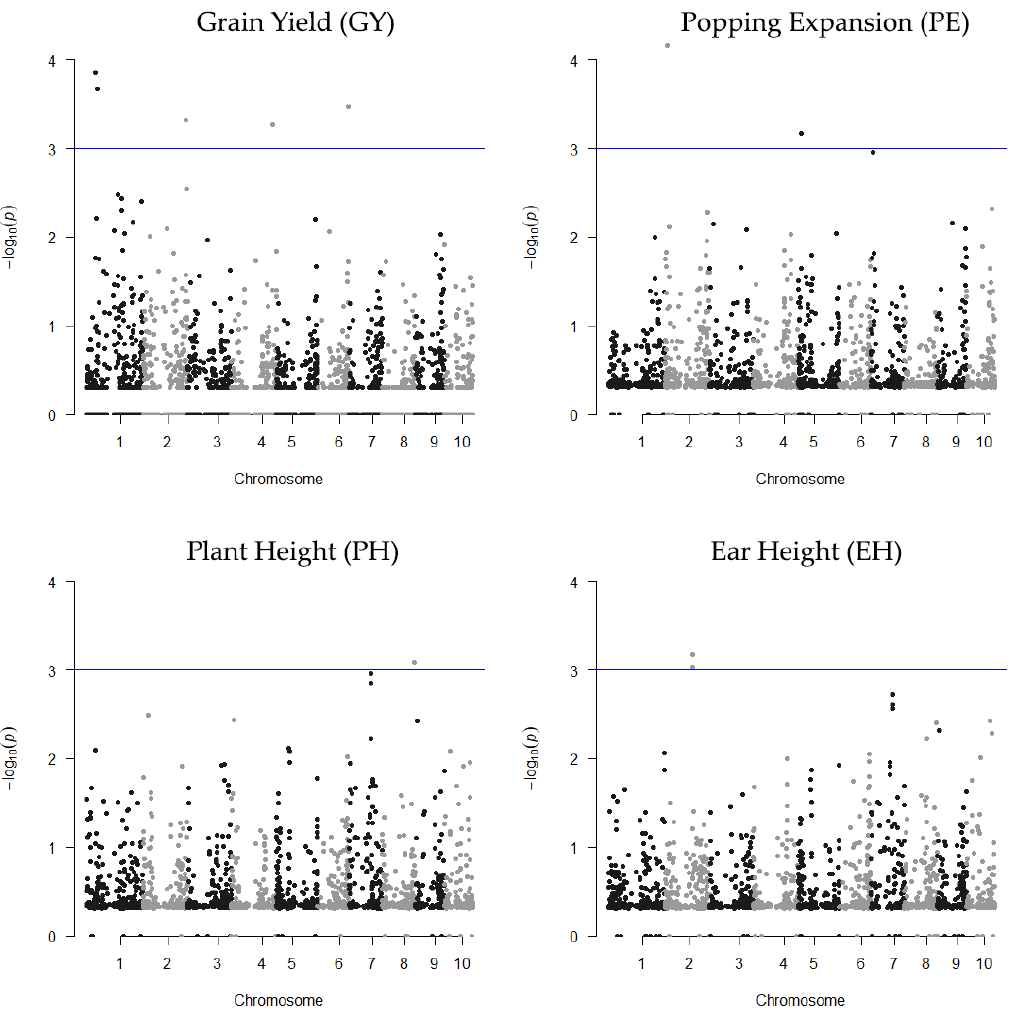
Figure 3. Manhattan plots of the statistical significance of the genomic regions associates with the GY, PE, PH, and EH traits in Campos dos Goytacazes (ENV1). The x-axis shows chromosomal positions and the y-axis shows − log 10 p -values. The blue horizontal line represents the genome-wide significance threshold ( p -value = 1 × 10 − 3 ).